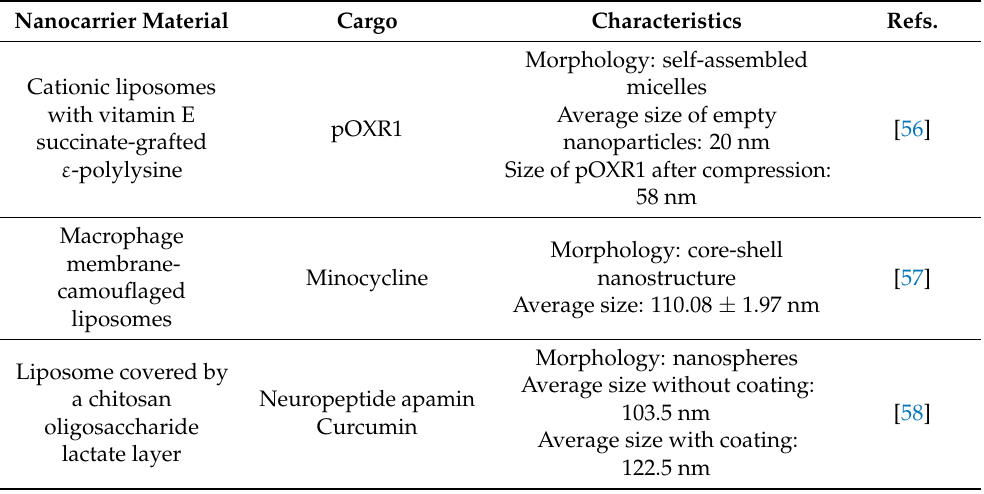
Table 4. Examples of liposomal nanosystems for spinal cord